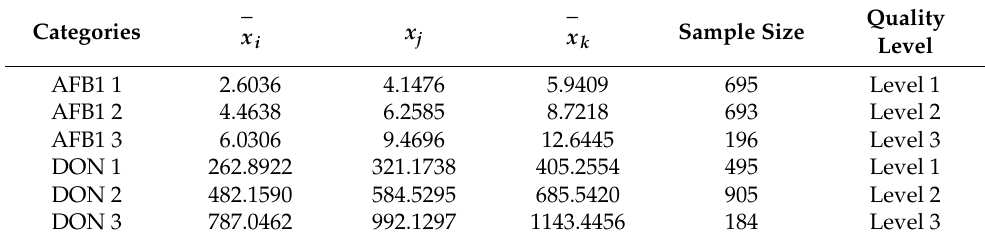
Table 5. Clustering centers and ranking of the three clusters of paddies.